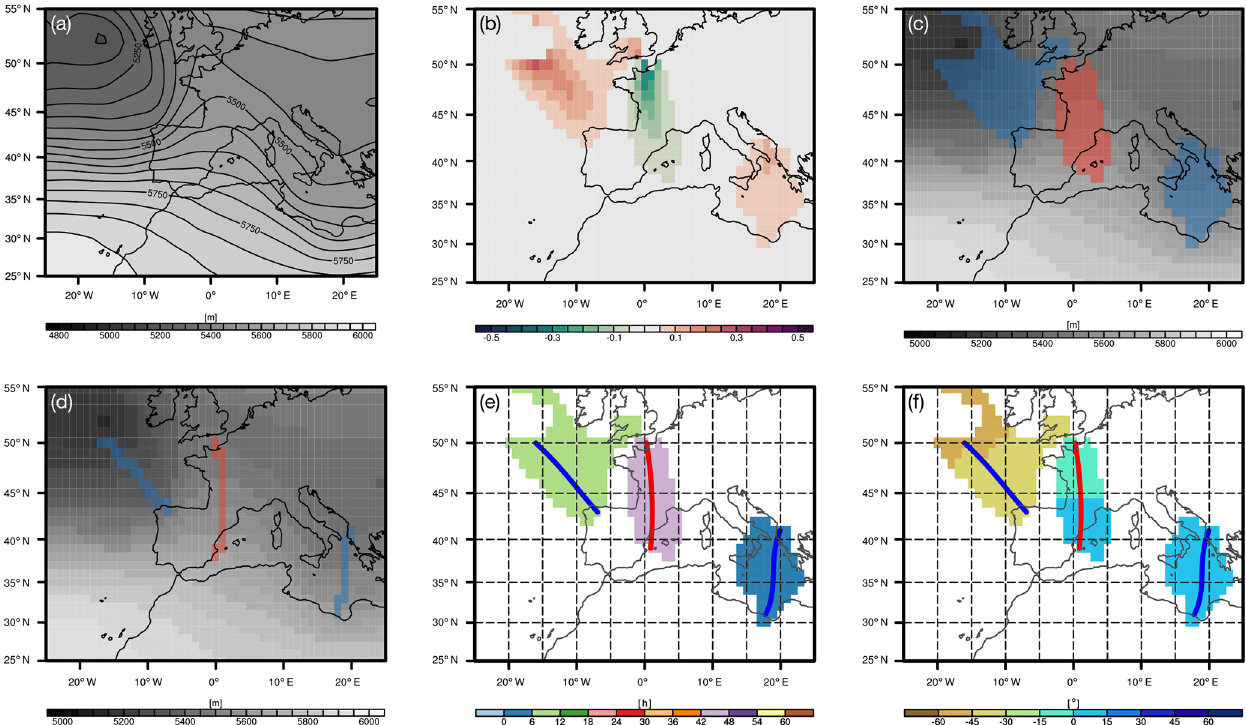
Figure 1. (a) The 500hPa geopotential height (m) at 12:00UTC on 12 January 2010. (b) Curvature of the geopotential isolines (units: ◦ km − 1 ) on the 1 ◦ × 1 ◦ input grid at every grid point where the curvature is larger than 0.05 ◦ km − 1 . (c) The 2D trough (blue) and ridge (red) masks and geopotential height (gray shading) at every grid point. (d) The corresponding trough (blue) and ridge (red) axes, (e) Cubic-spline interpolated trough and ridge axes and age (color; in h) of the trough and ridge features. (f) The horizontal orientation of the trough and ridge object (in degrees; angle relative to a north–south meridian and estimated from the corresponding